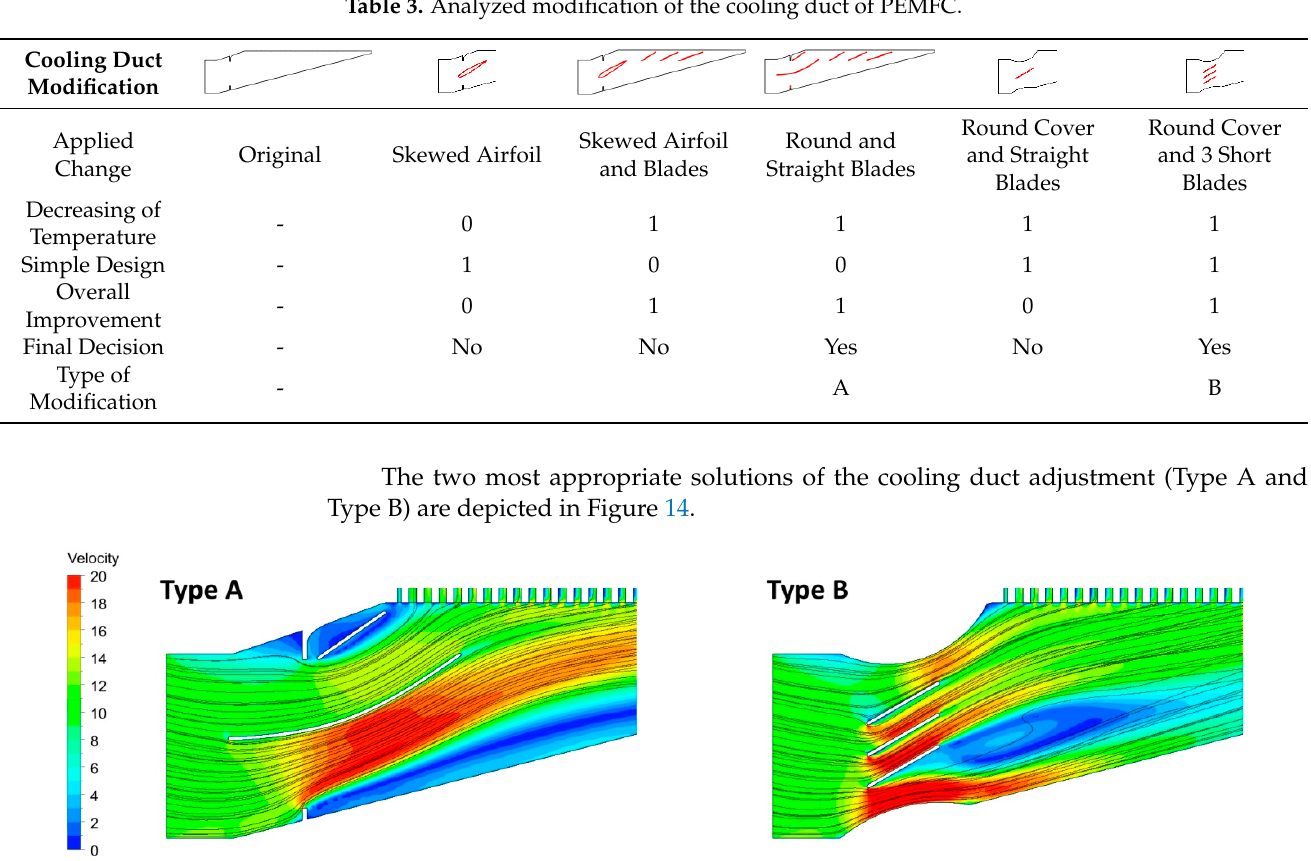
( b ) Figure 13. ( a ) Streamlines of the air coolant and ( b ) temperature distribution at P el = 1000 W of load. In the simulated model, the temperature differences are somewhat slightly higher. This is mainly due to the applied simplification of the CFD model, which does not take into account the complex construction of a real PEMFC. Additional devices (humidifier, control card, sensors, etc.) are placed on the sidewalls of the PEMFC structure, which gen- erally decrease the heat dissipation to the surroundings and thus increase its overall tem- perature. In the CFD model, temperature-dependent heat transfer coefficients have been ap- plied to the entire walls of the PEMFC stack, and the CFD model is generally better cooled. Thus, the simulated temperature distribution and values on our model differ. In the CFD model, we emphasized a precise computing network (mesh) in the air duct and the bound- ary layer between fluid and solid objects. The model contains more than 15 million ele- ments, and its solution is very time consuming. We believe that even with this simplifica- tion in the construction of the model, there can be found a fairly good match with real PEMFC. The internal plastic attachments are the integrated part of the radial fan assembly and cannot be simply removed. It is possible to slightly modify its height. To increase the air-